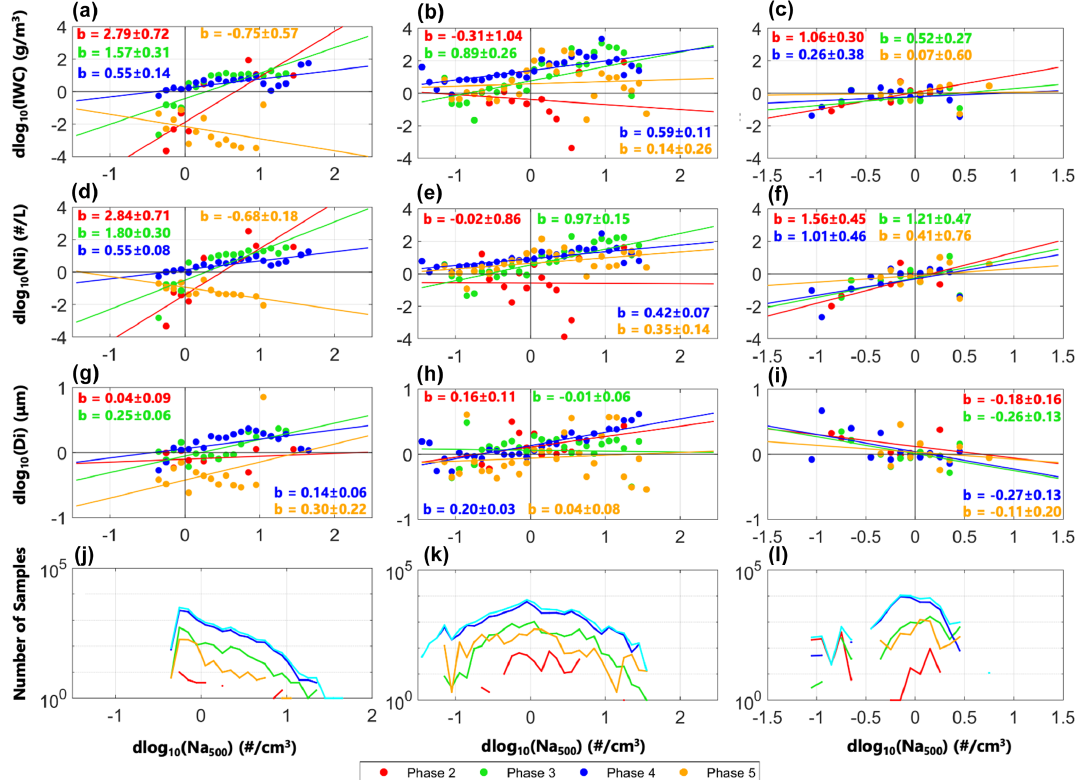
Figure 13. Similar to Fig. 10, except for using two NASA flight campaigns to analyze linear regressions with respect to dlog 10 (Na 500